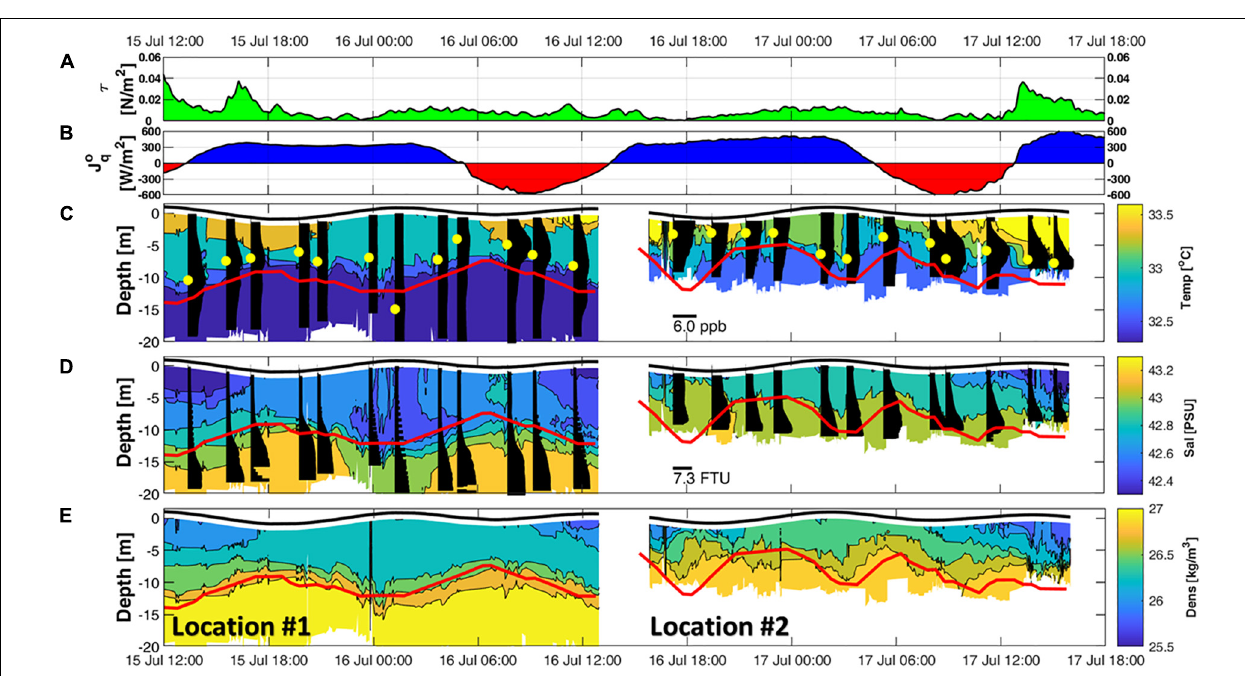
FIGURE 6 | Surface meteorological forcing and micro-CTD measurements at locations #1 and #2. (A) Wind stress. (B) Net heat flux where negative values (red) indicates net heating and positive values (blue) indicate net cooling. (C) Thermal structure overlaid with vertical profiles of chlorophyll a concentrations in black bars. Maximum chlorophyll concentration depths are indicated by yellow dots. (D) Salinity structure plotted over turbidity concentrations in black bars. (E) Density structure. Solid red lines (C–E) indicate the pycnocline